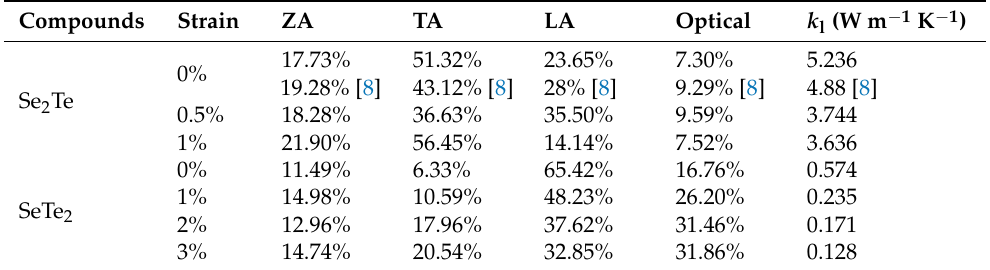
Table 2. Contributions of phonon modes (ZA, TA, LA, and all-optical) to total lattice thermal conductivity at 300 K, together with the lattice thermal conductivity k l